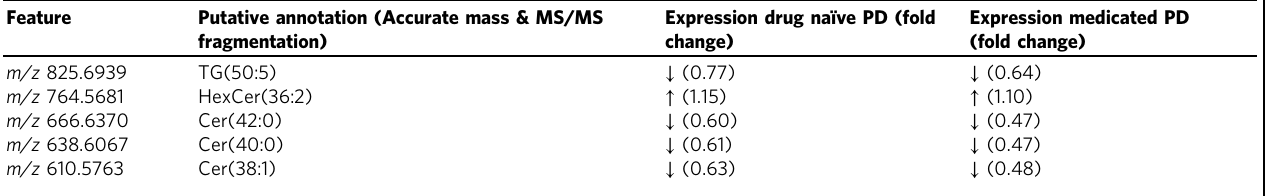
Table 2 Putative annotations of the ten VIP compounds common between drug naïve PD and medicated PD analyses (VIP > 1). (A) Putative annotations have been assigned using accurate mass and MS/MS fragmentation matched against Lipid Maps database (LMSD) and Lipid Blast.